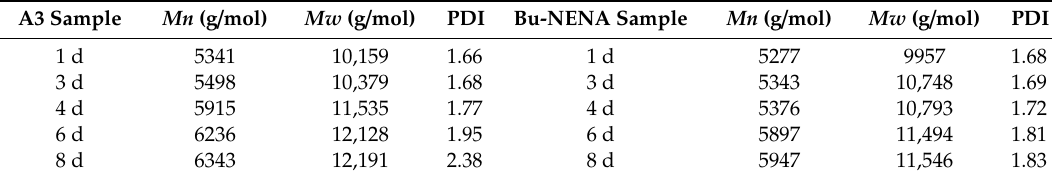
Table 1. Analysis data of the uncrosslinked polymer samples in PTPET.